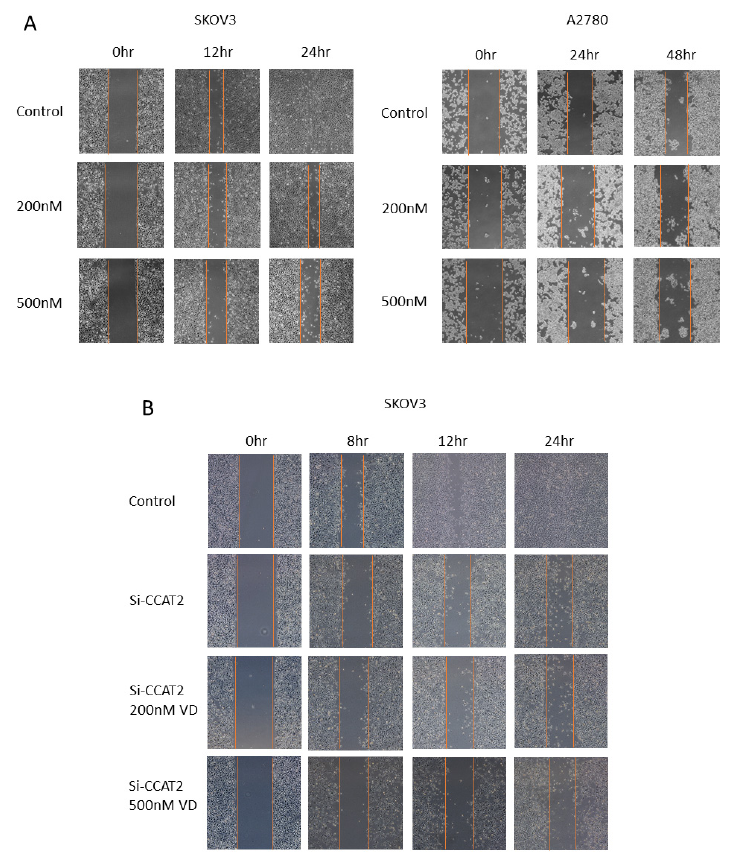
Figure 4. Calcitriol inhibited the directional migration of ovarian cancer cells. ( A ) Calcitriol inhibited the movement to the scratched area by SKOV3 and A2780 cells in a dose-dependent manner. ( B ) SKOV3 cells were transfected with siRNA targeting CCAT2. Following siRNA transfection, cells were treated with 200 nM and 500 nM calcitriol, respectively. The wound closure was observed using a microscope (scale bars: 200 µm).